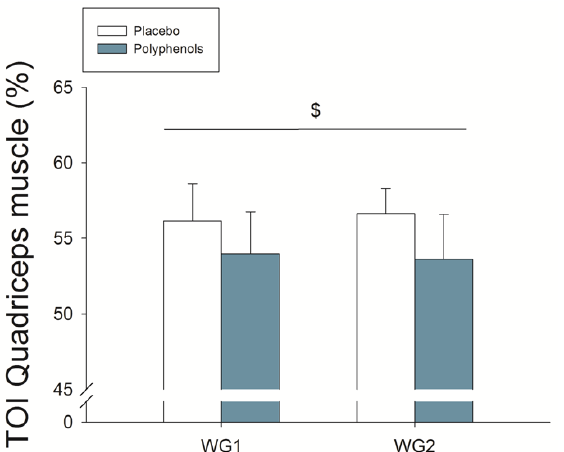
Figure 4. Quadriceps muscle oxygenation index (TOI, mean of the musculus vastus lateralis and vastus medialis ) during the first two 30 s Wingate tests after the ingestion of polyphenols (mangiferin + luteolin) or placebo. Number 1 indicates after 48 h and 2 after 15 days of supplementation. $ p < 0.05 for treatment effect. N = 12.